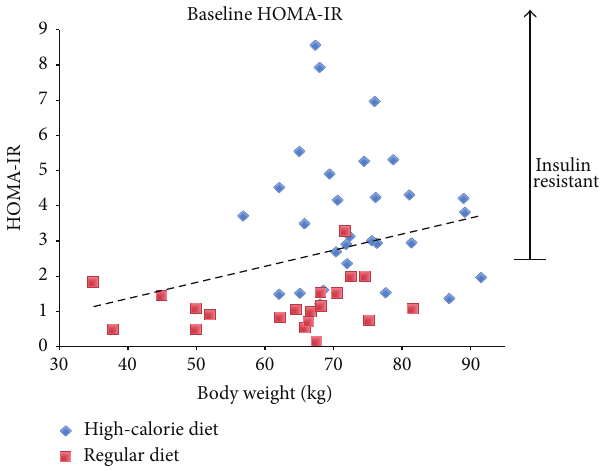
Figure 1: Preoperative body weight and HOMA-IR in high-calorie and regular diet Ossabaws. Scatter plot of preoperative weight and HOMA-IR in pigs exposed to the high-fat, high-calorie diet for > 180 days and those maintained on a normal diet. The dashed regression line shows overall mild positive correlation between weight and HOMA-IR ( 𝑅 2 = 0.08 , 𝑃 = 0.05 ). Insulin resistance in this model was defined as HOMA-IR > 2 standard deviations above the regular diet group mean ( >